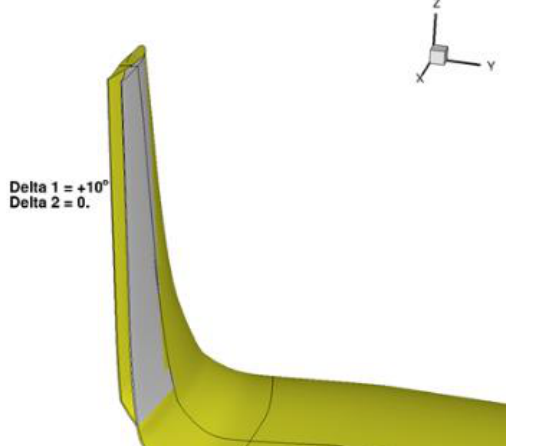
Figure 7 . Synchronous deployment of the upper and lower morphing tabs of the winglet, [34,37]. Figure taken with permission from authors.